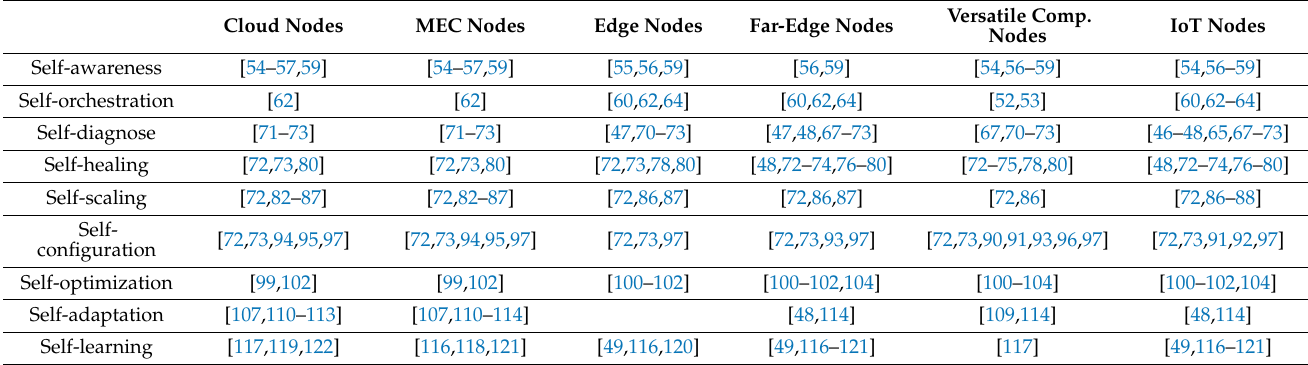
Table 1. Evaluated works for each self-* capability and their spot in the continuum. Cloud Nodes MEC Nodes Edge Nodes Far-Edge Nodes Versatile Comp.